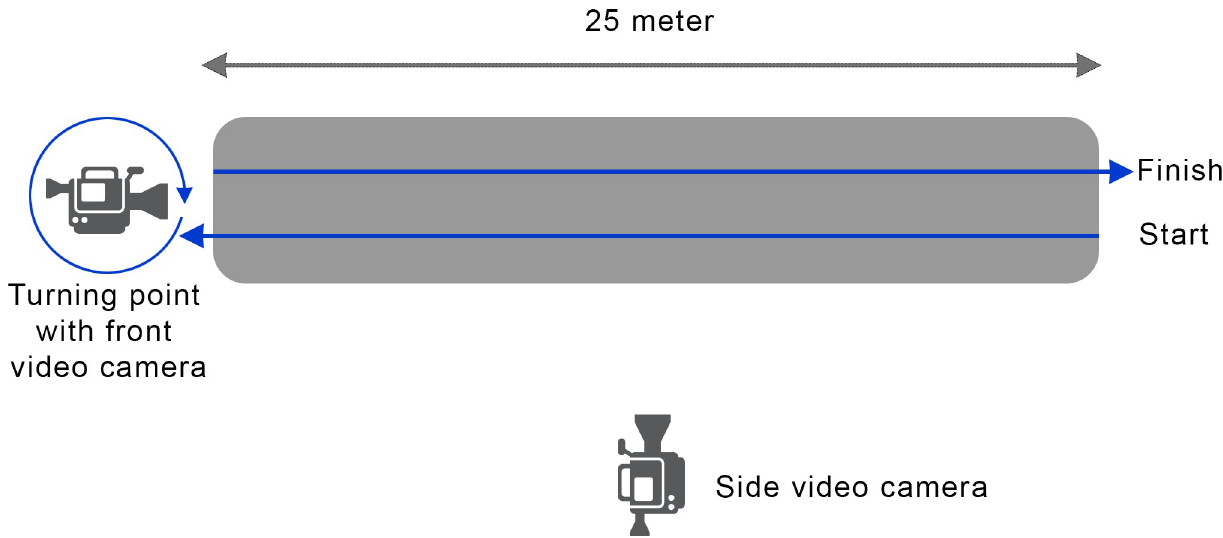
Fig 1. Setup of experiment: 25 meters hard straight line, showing start, finish and the position of front and side video cameras used to film the horses during walk and trot, back and forth.